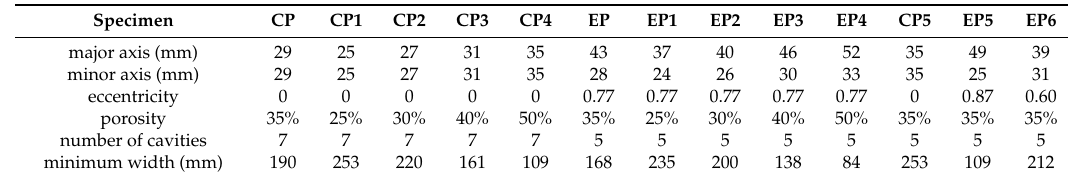
Figure 1. Dimensions of the partition wall (in mm): ( a ) current model used in the building industry; ( b ) proposed model; and, ( c ) microstructure of the cement-based materials. Table 1. Dimensions of the